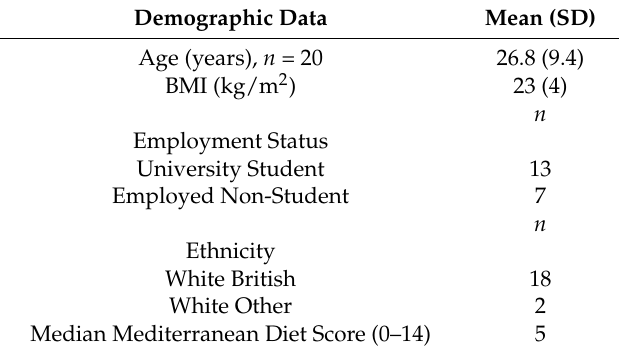
Table 1. Participants’